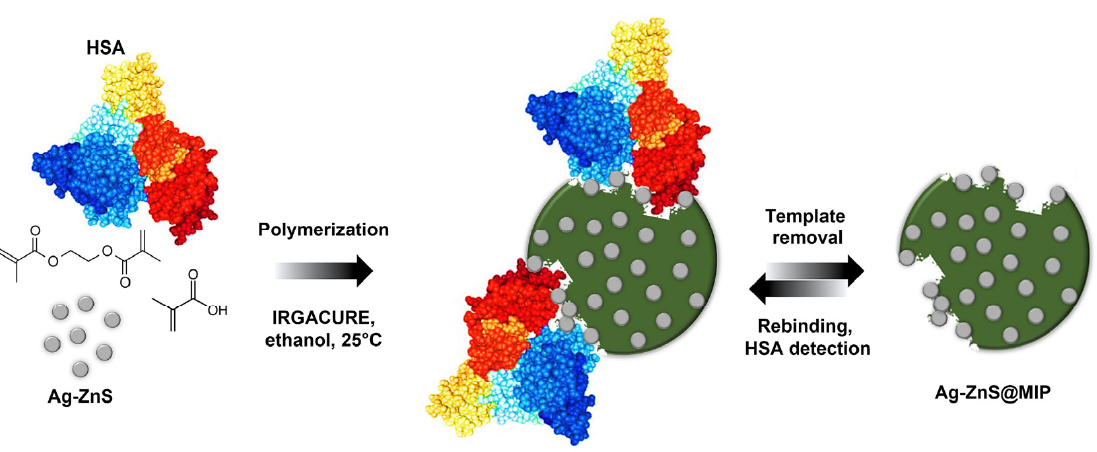
Figure 1. A schematic for the synthesis of human serum albumin (HSA)-imprinted Ag-ZnS@MIP composite receptors.